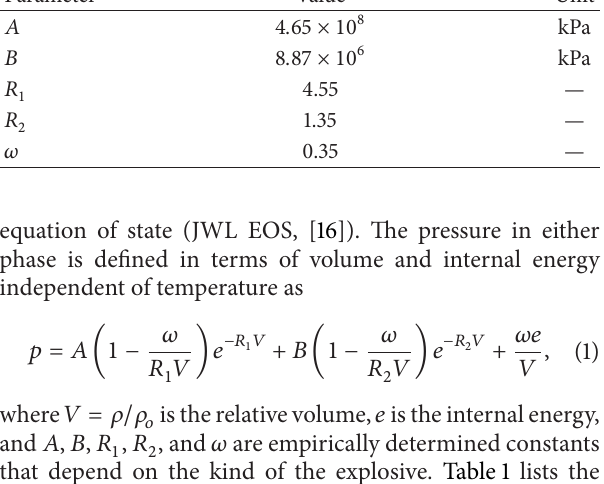
Figure 11: Pressure loading